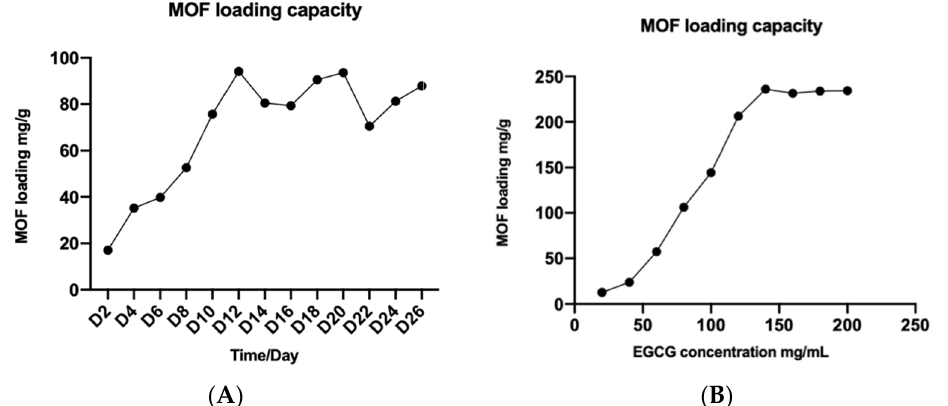
Figure 3. Optimizing MOF Zn(BTC) 4 -EGCG loading. ( A ) The loading capacity of MOF Zn(BTC) 4 on EGCG over time; ( B ) The influence of different EGCG concentrations on EGCG@MOF Zn(BTC) 4 loading capacity.